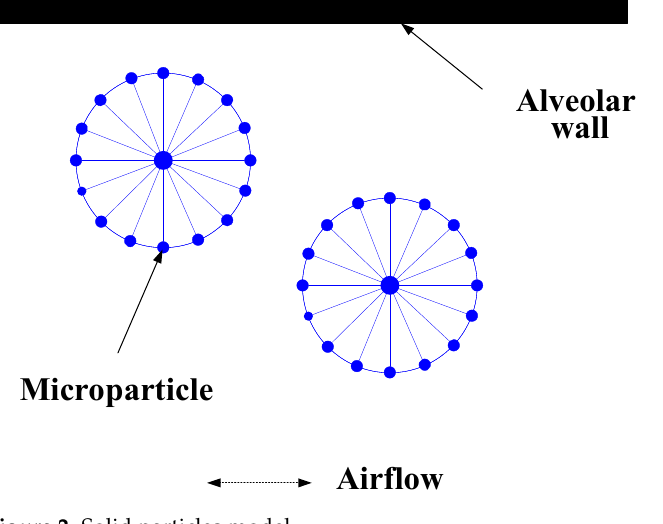
Figure 2. Solid particles model.